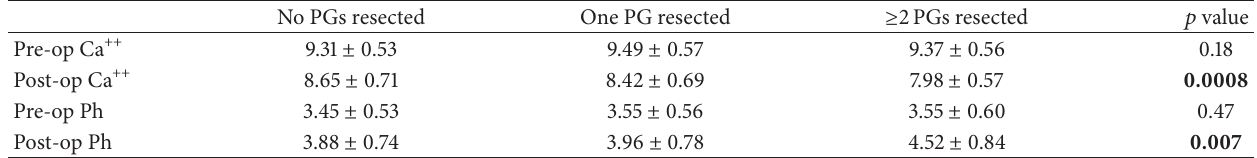
Table 4: Pre- and postoperative calcium (Ca ++ ) and phosphate (Ph) levels.